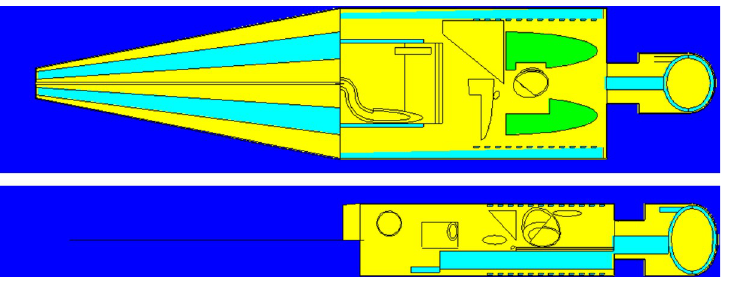
Fig 2. The Oak Ridge National Laboratory (ORNL) adult male human phantom [1] used in the present